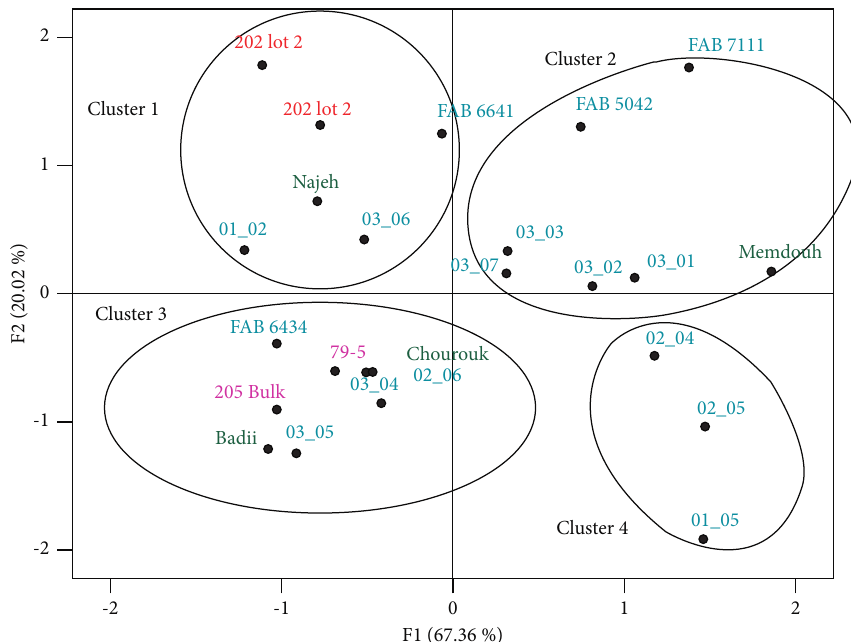
Figure 5: Principal component analysis performed by using 18 quantitative seed traits and 24 faba bean germplasm accessions.